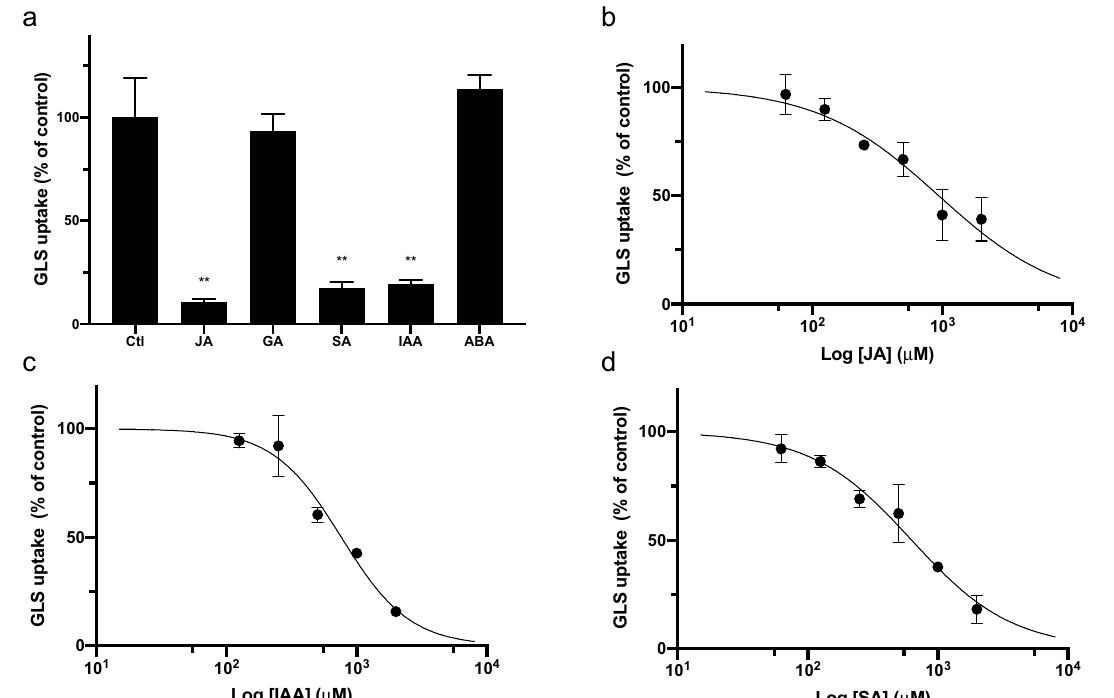
Figure 4. The addition of JA, IAA, and SA inhibited the transport of GLS via AtGTR1. ( a ) Yeast GLS uptake activity was evaluated in the presence of various acidic phytohormones. In each experiment, yeast cells expressing AtGTR1 were incubated with 25 μM GLS and 500 μM phytohormones for 1 h. GLS contents in the yeast cells were quantified by RP-HPLC and were normalized to the average value of the control group. Ctl control group, without adding phytohormones, JA jasmonic acid, GA gibberellic acid, SA salicylic acid, IAA indole-3-acetic acid, and ABA abscisic acid. Bar values are the means of three independent replicates. Error bars indicate SD. Significant differences were assessed by unpaired two-tailed Student t-test and are indicated by ** p < 0.01. ( b–d ) Concentration–response curves for the inhibition of GLS uptake by addition of ( b ) JA, ( c ) IAA, and ( d ) SA. Various concentrations of the phytohormones were treated to inhibit GLS transport in yeast uptake assay. The GLS contents in yeast cells were quantified and normalized to the mean of the control group. Concentration–response curves were fitted using nonlinear regression. Corresponding IC 50 values for JA, IAA, and SA are 937.8 μM, 762.1 μM and 630.0 μM, respectively. Each data point represents mean ± SD (n =